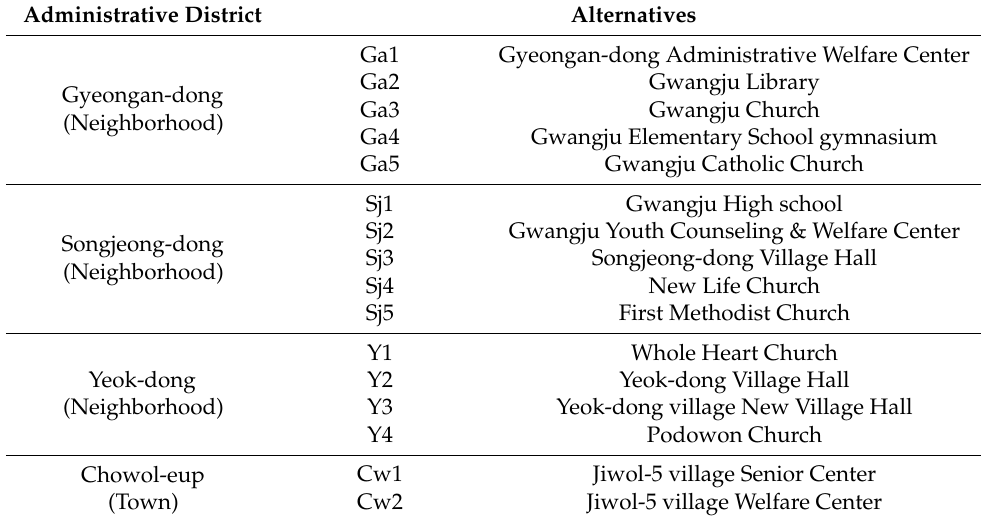
Table 4. Identification of shelter alternatives by administrative